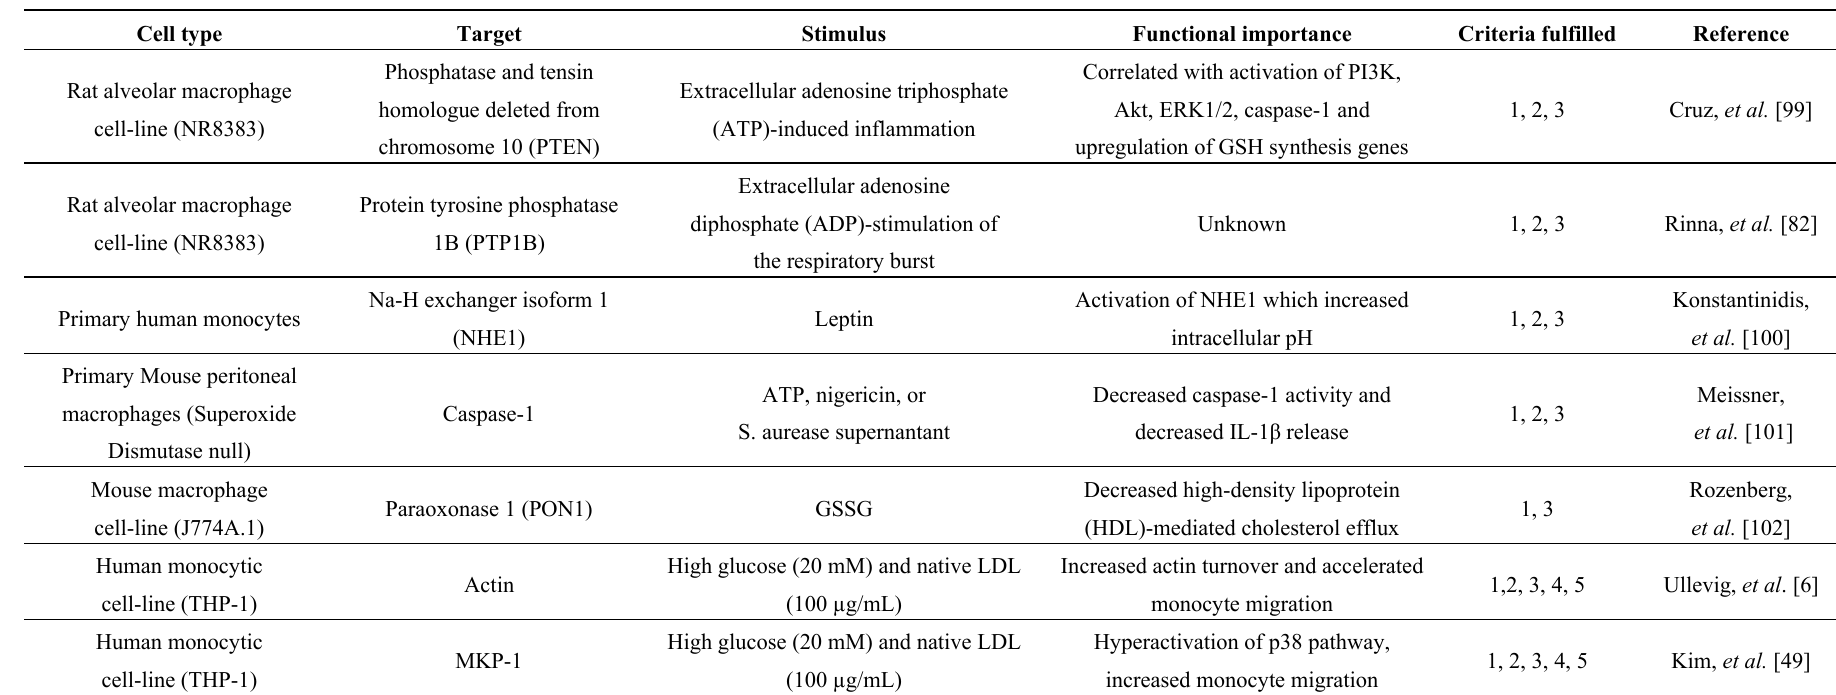
Table 2. Summary of S -Glutathionylated Proteins in Monocytes and